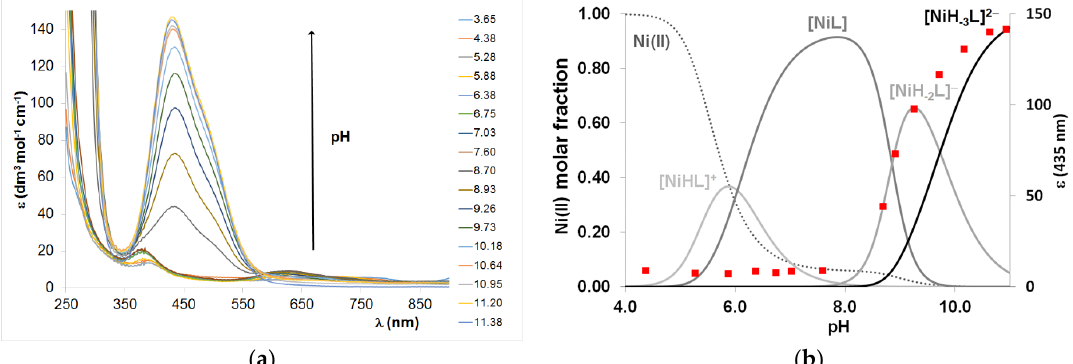
Figure 10. UV–Vis spectra ( a ) and concentration distribution curves of equimolar solution of Ni(II):Ac-HADHAH-NH2 system and the absorption values at 435 nm in function of pH (cL = 2 mM) ( b ).